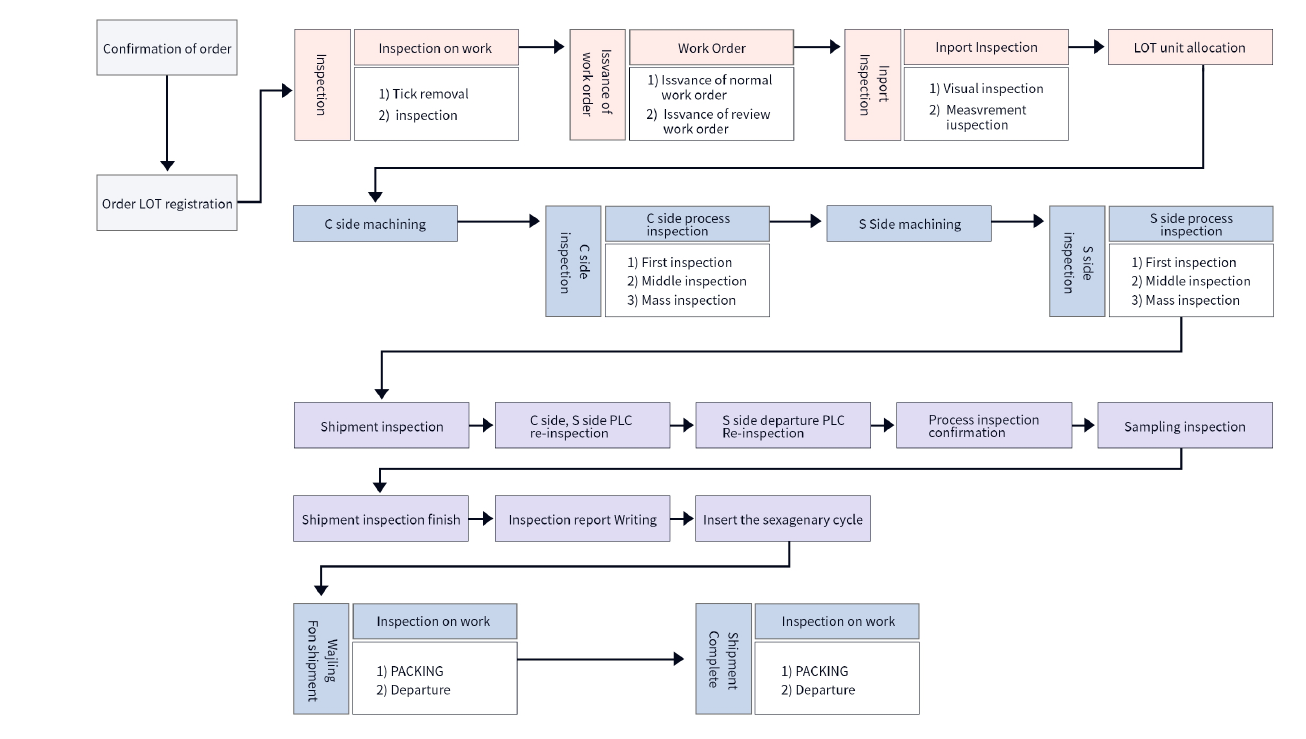
Figure 13. A flow chart for each major